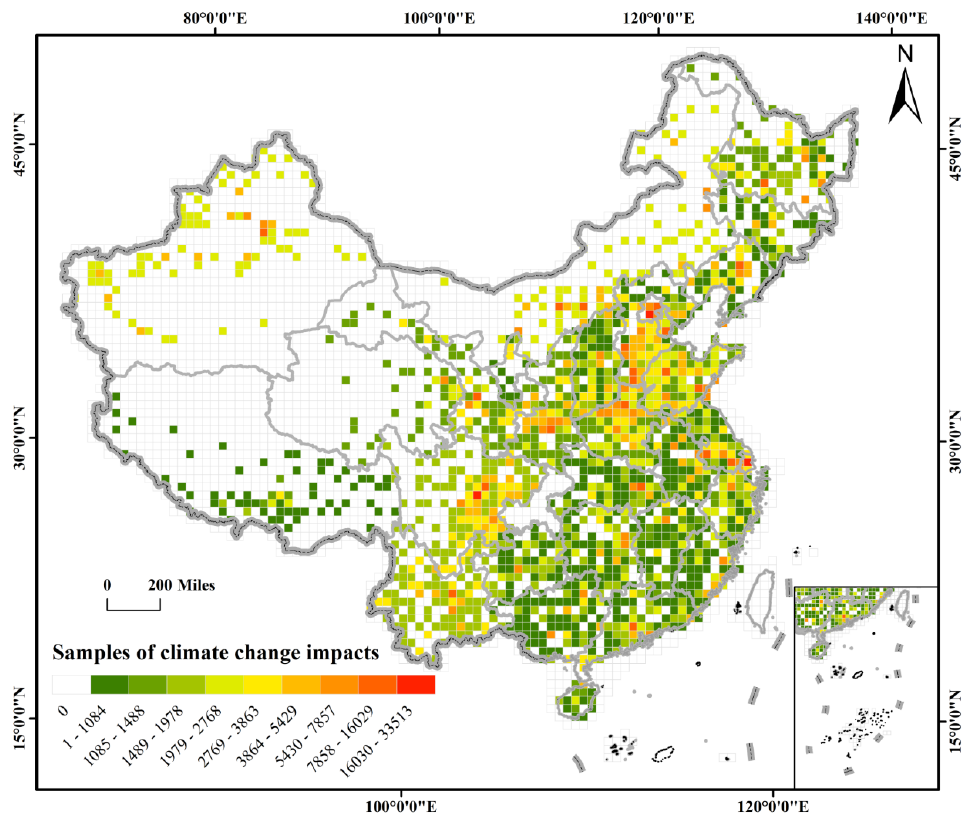
Figure 3. Geographic map of the impact of climate change studies.